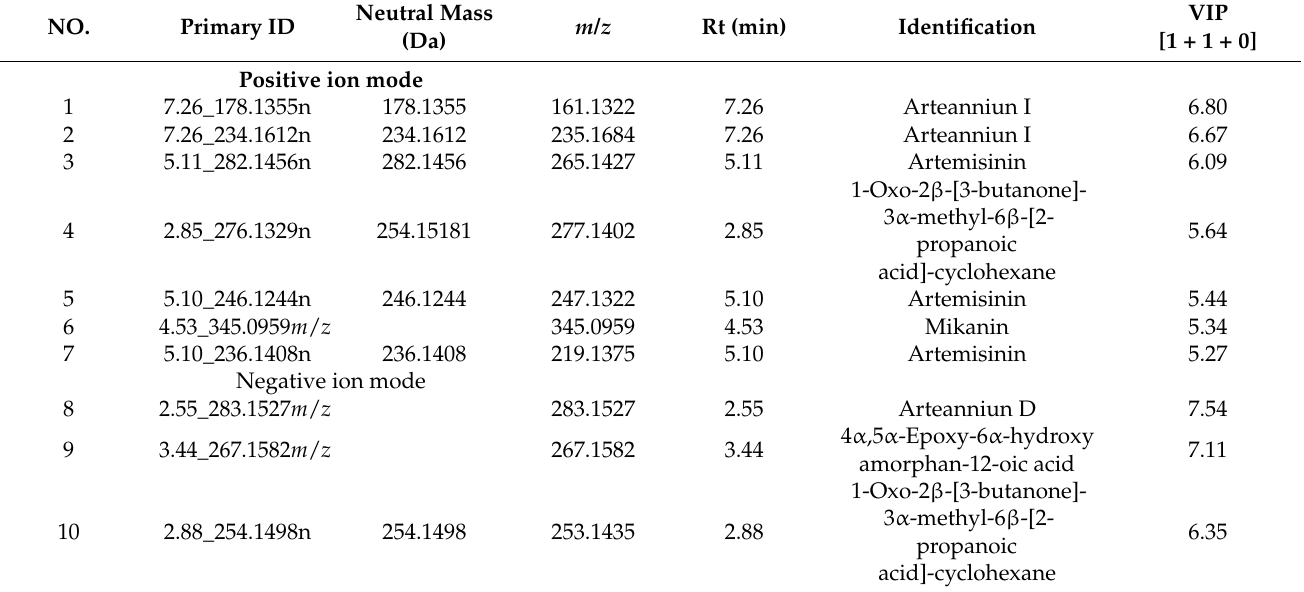
Figure 3. OPLS-DA of ArtL-Et 2 O and ArtH-Et 2 O. ( A ) Score plot in positive ion mode. ( B ) S-plot in positive-ion mode. ( C ) Score plot in negative-ion mode. ( D ) S-plot in negative-ion mode. Red dots represent VIP > 5 data. ( n = 3). Table 4. The differential chemical compositions positively correlated with antimalarial activity between ArtL-Et 2 O and ArtH-Et 2 O.